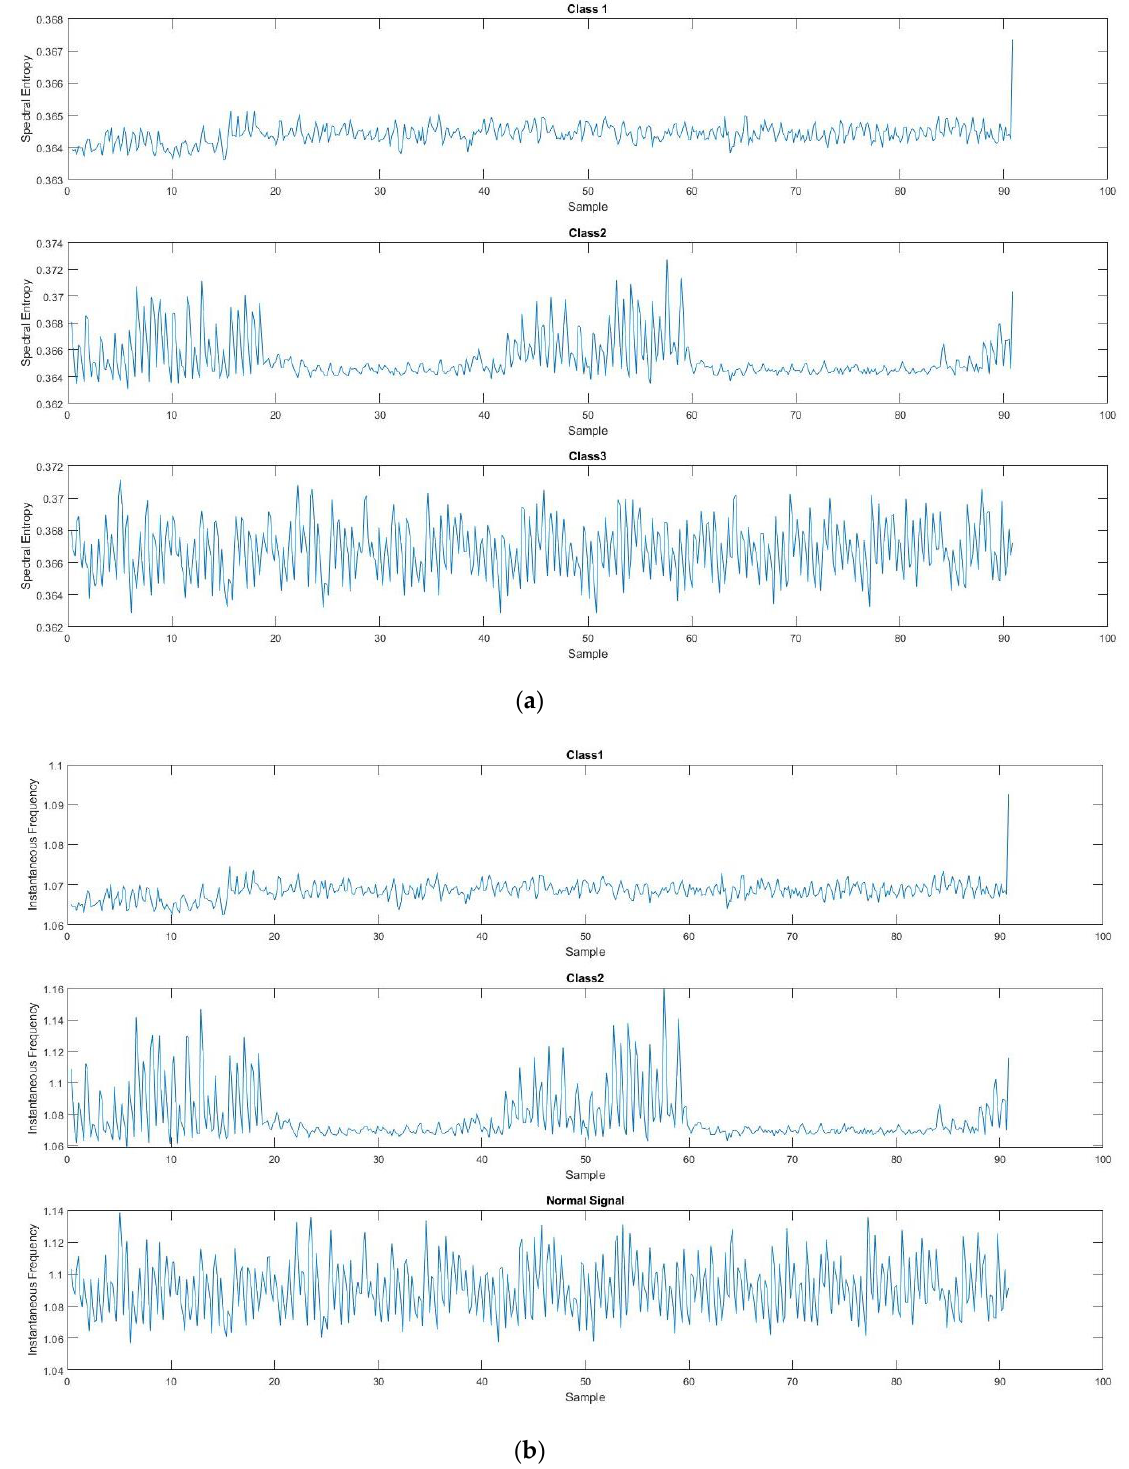
Figure 11. Three signals with features extracted, using spectral entropy ( a ) and instantaneous frequency ( b ).